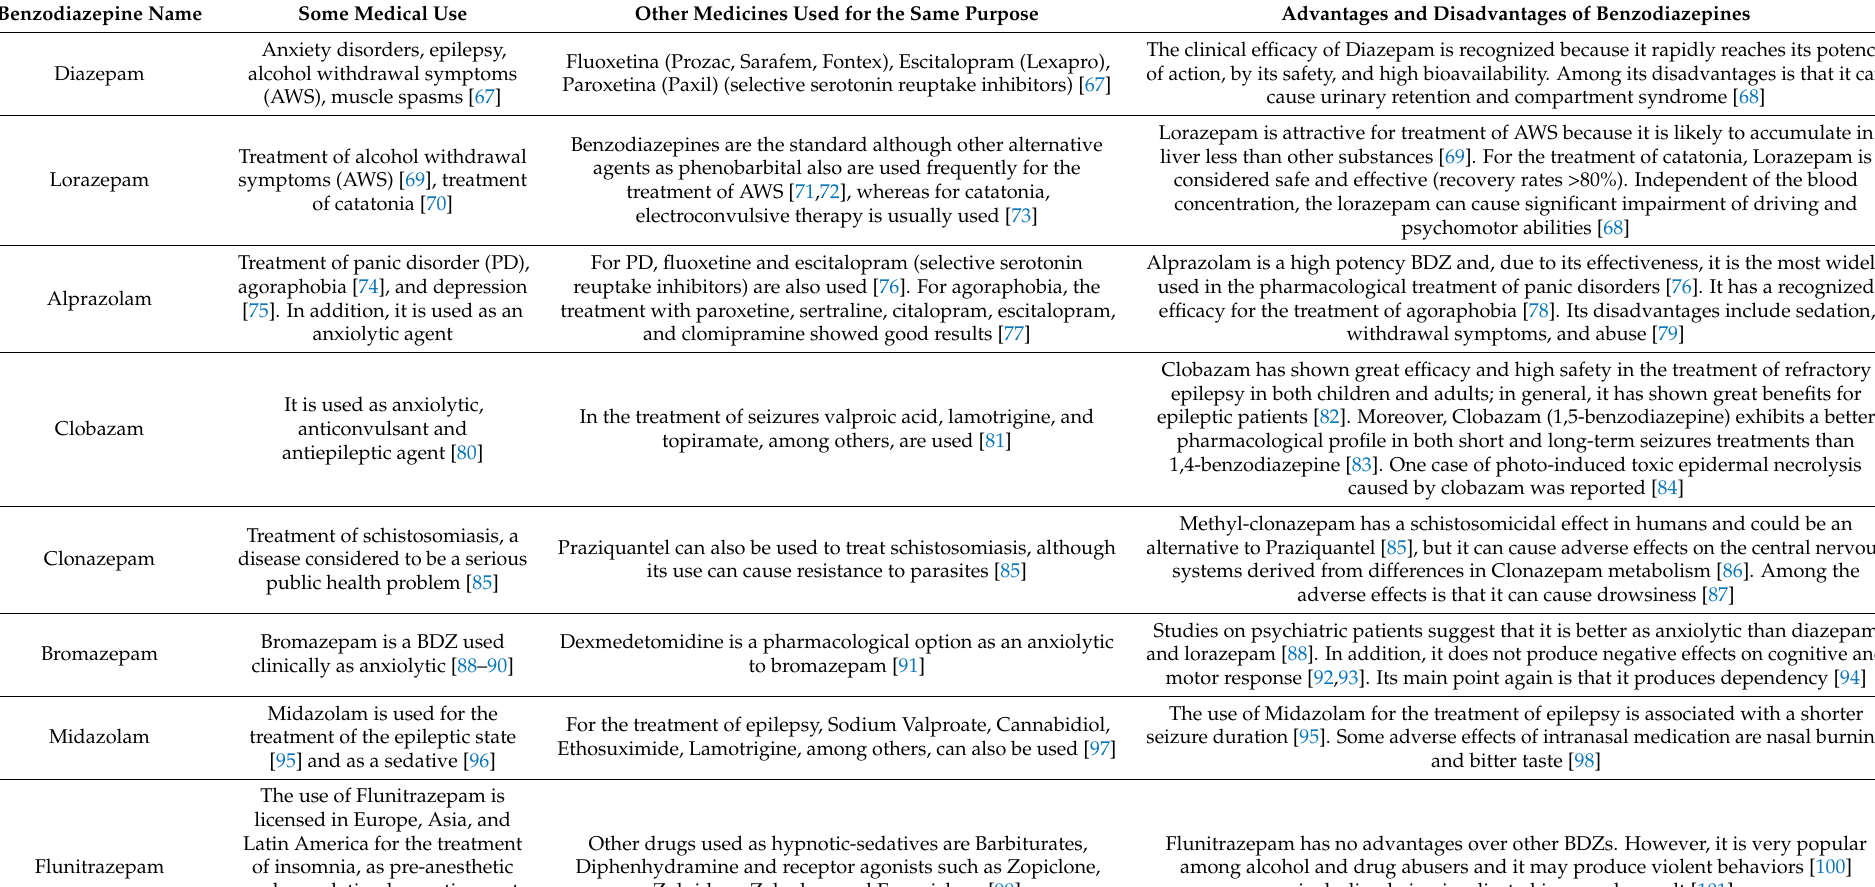
Table 1. Medical uses of benzodiazepines and the comparison with other medicines used for the same